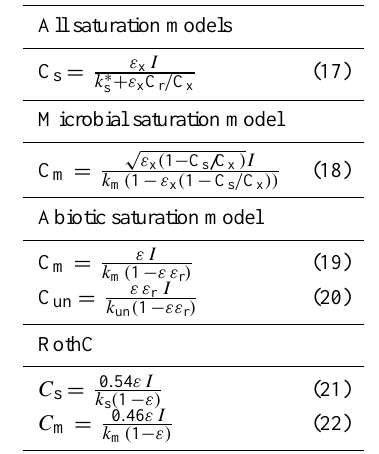
Table 4. The analytical solution to r cr in each model. Single-pool